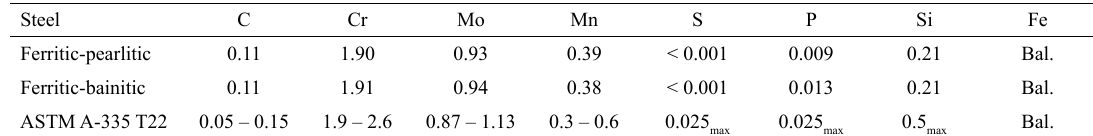
Table 1: Chemical composition (%wt) of the studied steel and the ASTM A 335 T22 specification. Steel